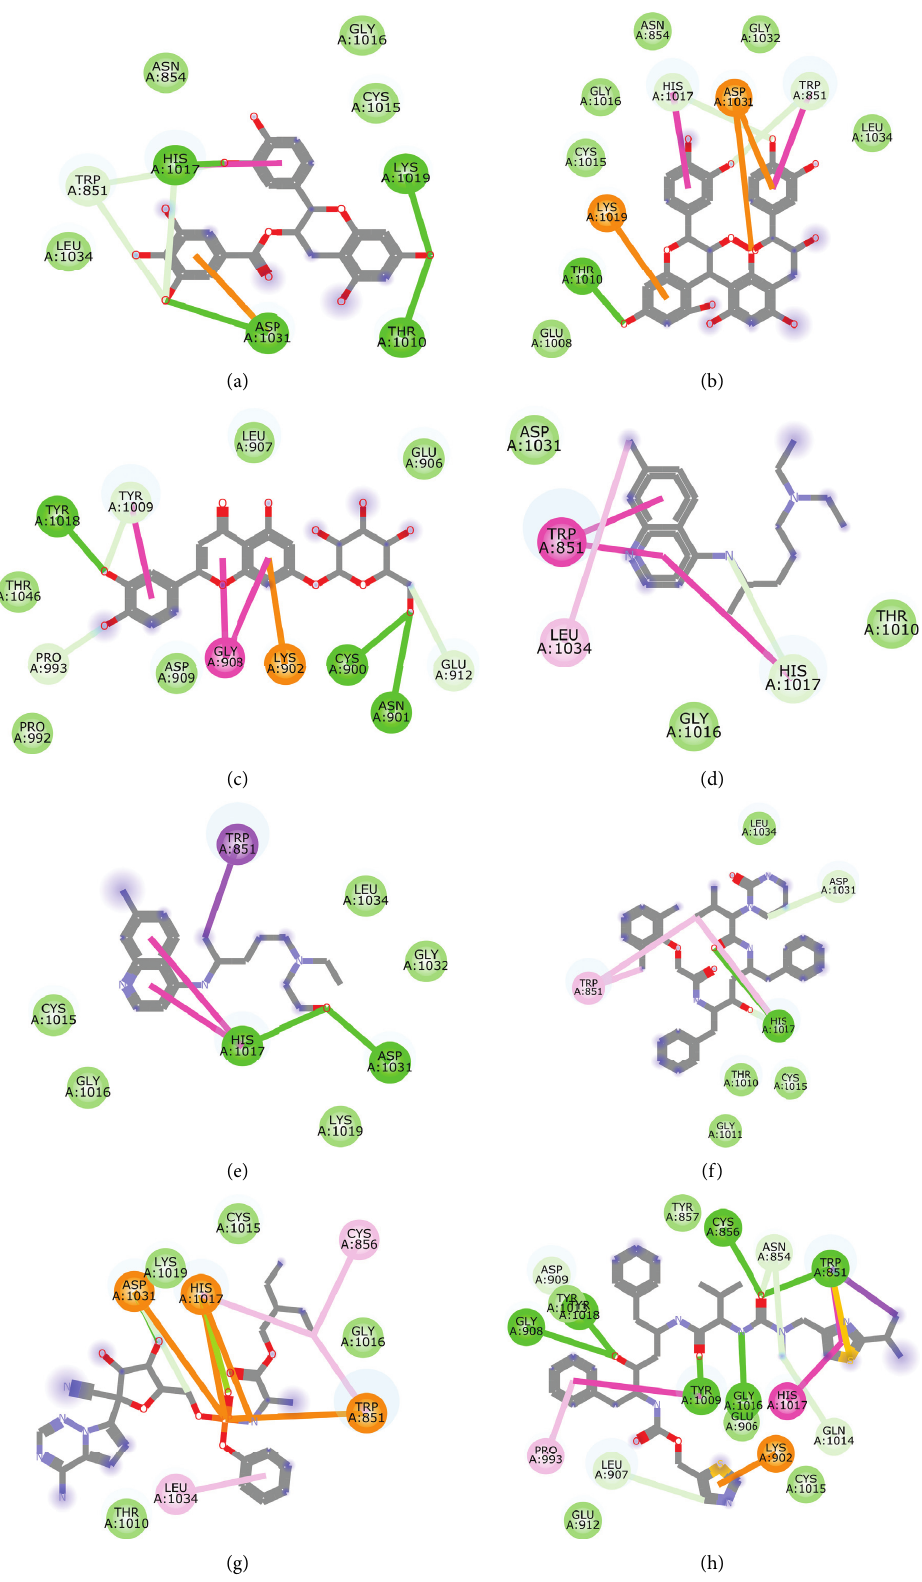
Figure 1: 2D representation of (a) 3-galloylcatechin, (b) proanthocyanidin B1, (c) luteolin 7-galactoside, (d) chloroquine, (e) hydrox- ychloroquine, (f) lopinavir, (g) remdesivir, and (h) ritonavir in the binding pocket of PLpro. Hydrogen, carbon-hydrogen, and π bonds are depicted as green, light blue, and any other coloured (purple, magenta, orange, turquoise blue, pink, and yellow) lines, while Van der Waal interactions appear as light green